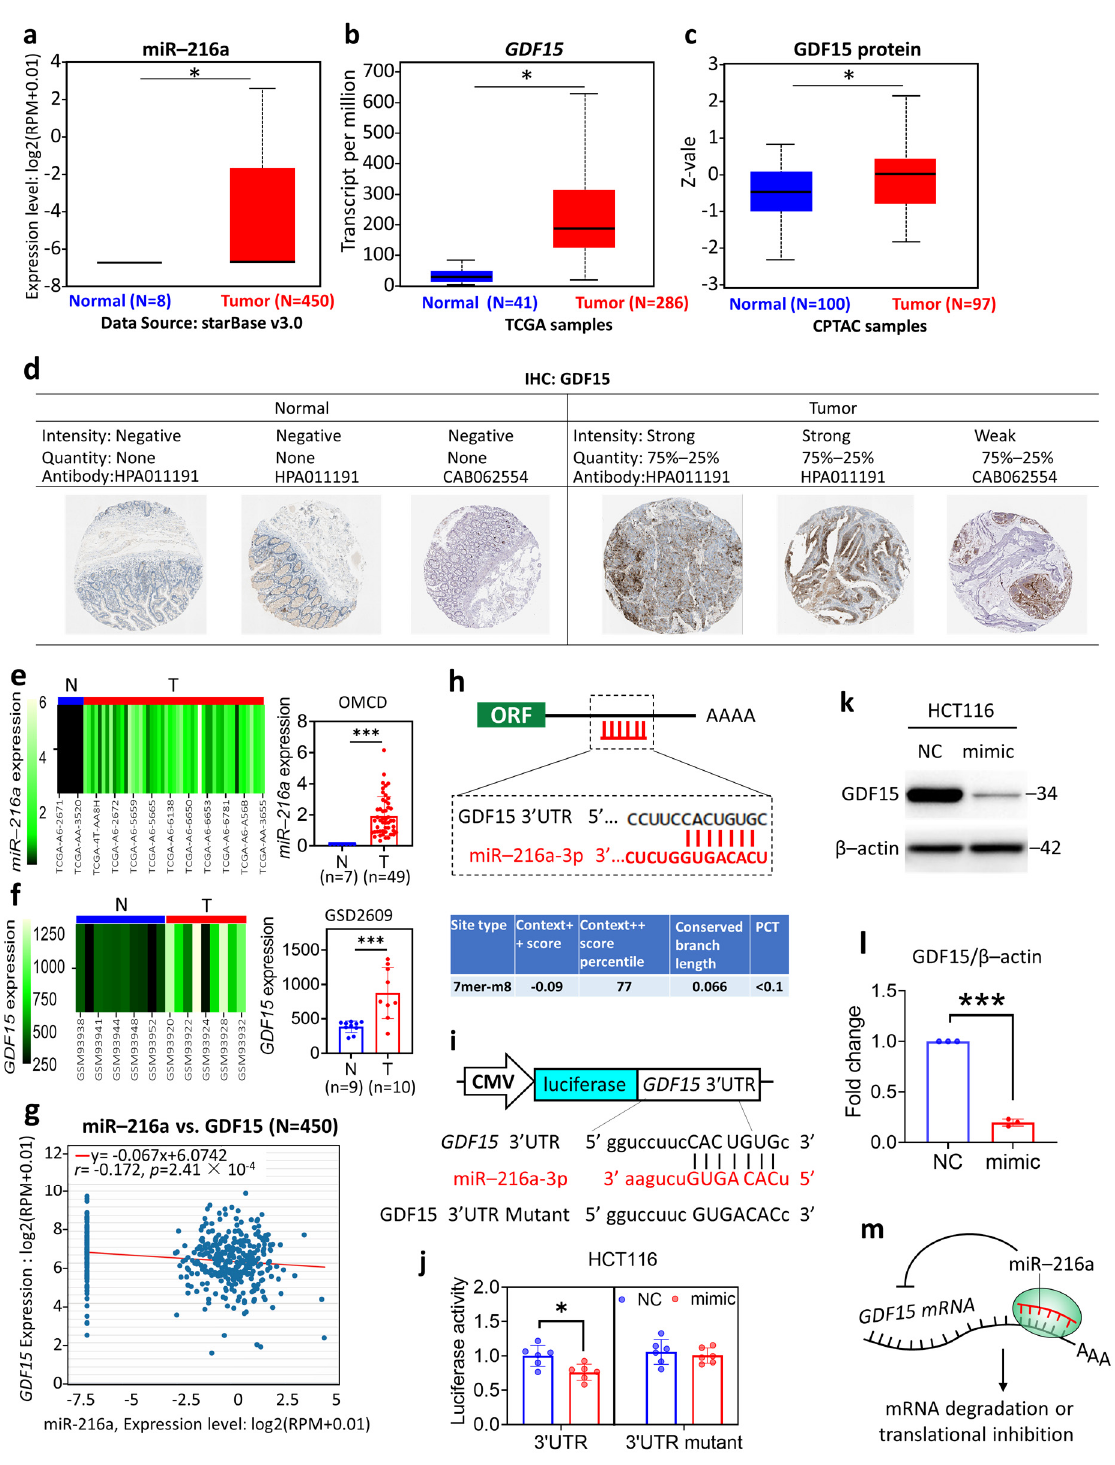
Figure 1. Differential expression analysis and the molecular interaction of microRNA (miR)-216a and growth differentiation factor 15 ( GDF15 ). The gene expression levels of miR-216a ( a ) and GDF15 ( b ) in normal and colon adenocarcinoma (COAD) tumor tissue. The protein expression levels ( c ) and the immunohistochemistry staining ( d ) of GDF15. ( e ) Heatmap and histogram of the expression levels in normal and COAD tumor tissue retrieved from OMCD (N, normal; T, tumor). ( f ) Heatmap and histogram of GDF15 expression levels in COAD tumor tissue retrieved from GSD2609 of the GEO data- base (N, normal; T, tumor). ( g ) Pearson’s correlation of miR-216a and GDF15 gene expression levels retrieved from The Encyclopedia of RNA Interactomes (ENCORI). ( h ) Target scan human-based bioinformatics prediction of the complemen- tary relationship between miR-216a-3p and GDF15 3 ′ untranslated region (UTR). ( i ) Graphic illustration of the luciferase